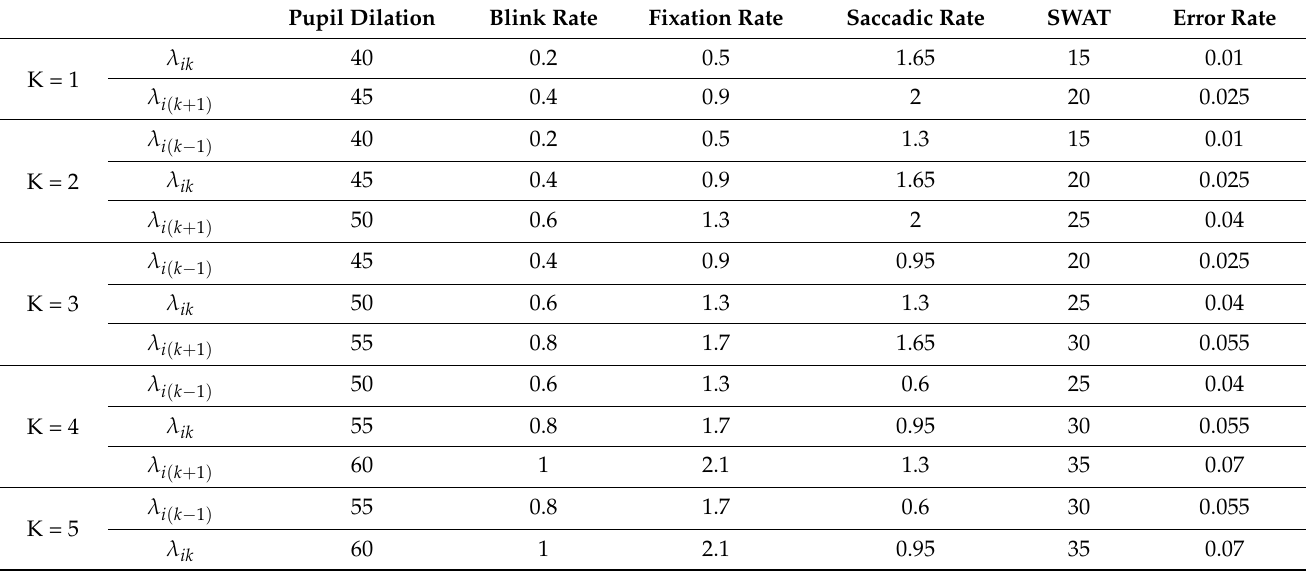
Table 5. Parameter values in membership